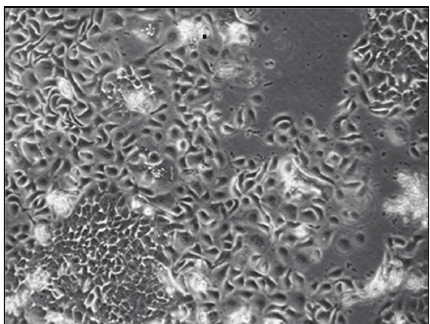
F 1: Morphology of MCF10DCIS and human breast cancer cell line in